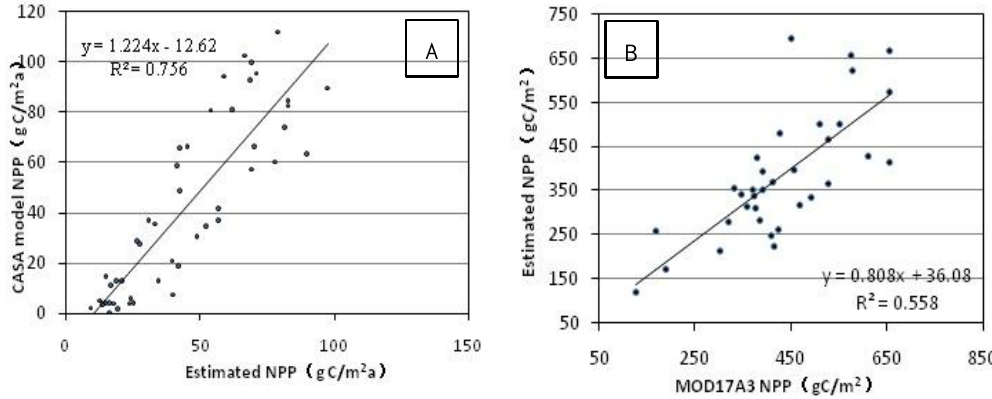
Figure 9. Comparison of NPP values among the estimated model, the CASA model (A) and MOD17 (B).